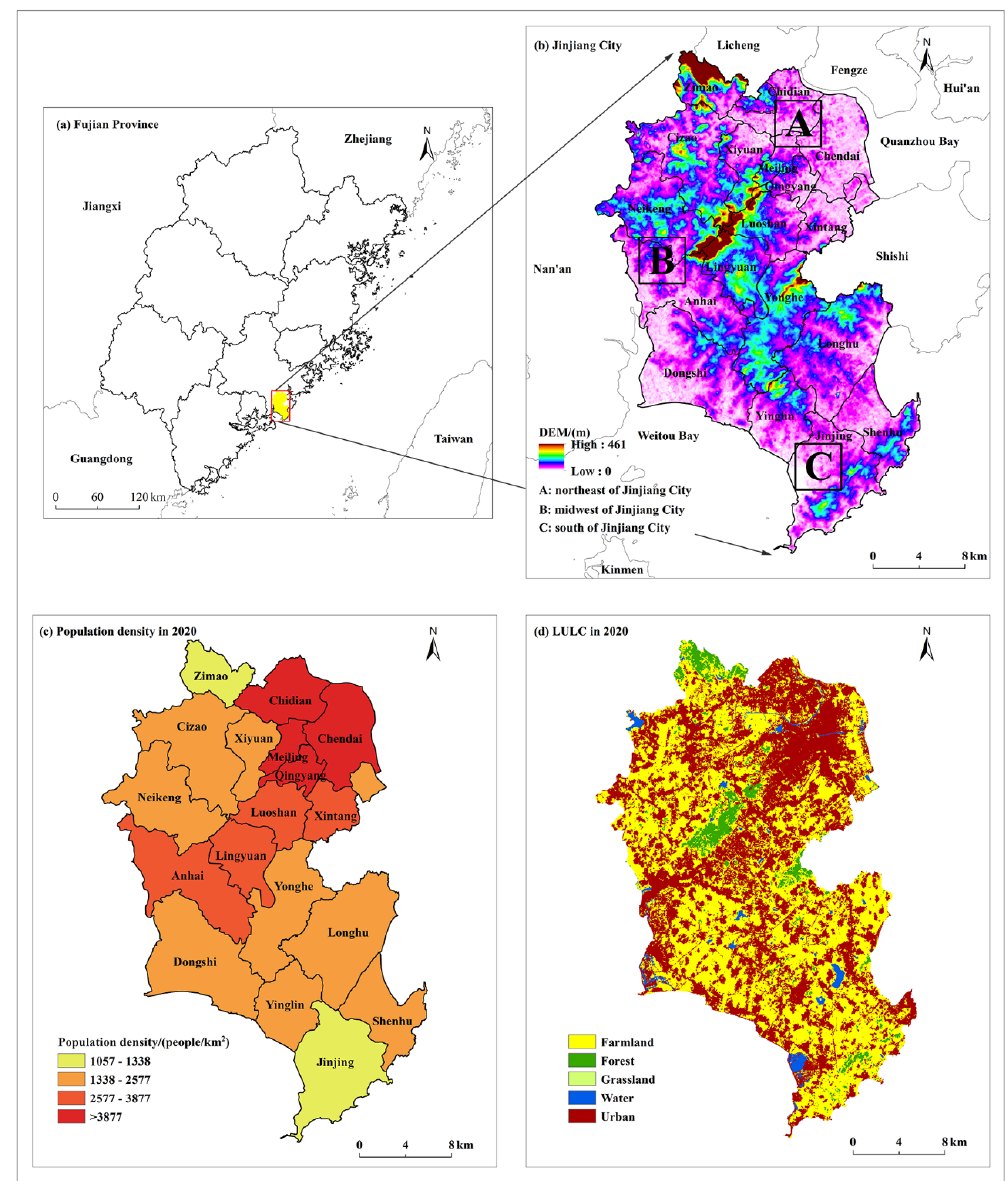
Figure 1. Case study area: Jinjiang, Fujian Province, China.